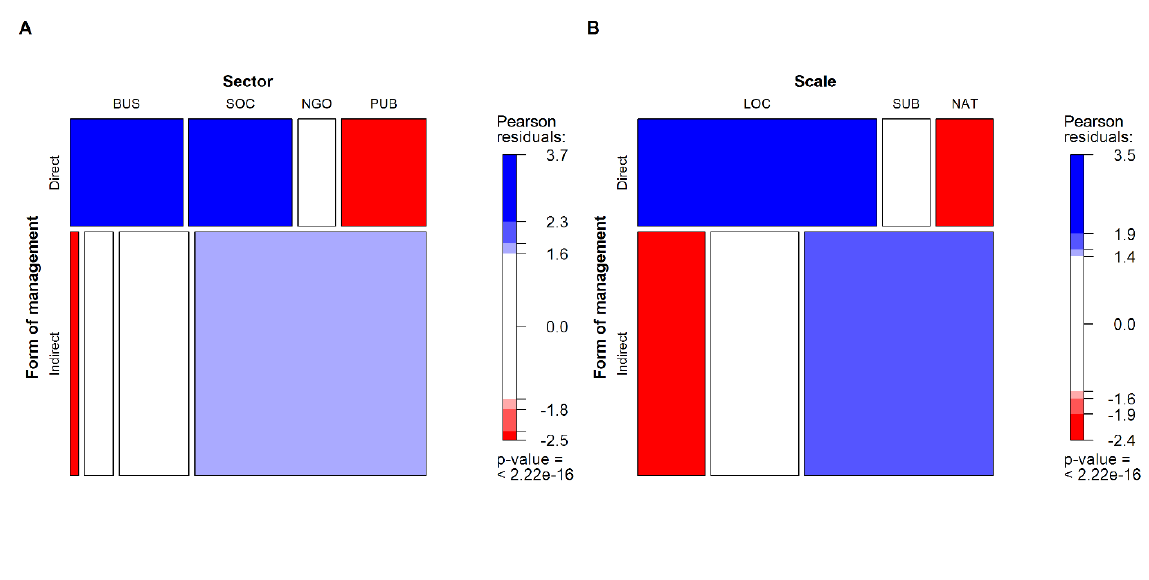
Figure A5.2. Mosaic plots of the frequency of the involvement of different stakeholder groups to different form of ES management (Direct/Indirect management). Each box is associated with a form of management in left list (Direct and Indirect forms of management) and stakeholders groups in top list (type of stakeholder in panel A and scale of influence of stakeholder in panel B). The height of a box is proportional to the number of observations of the corresponding form of management. The width of a box is proportional to the number of stakeholders in each group.